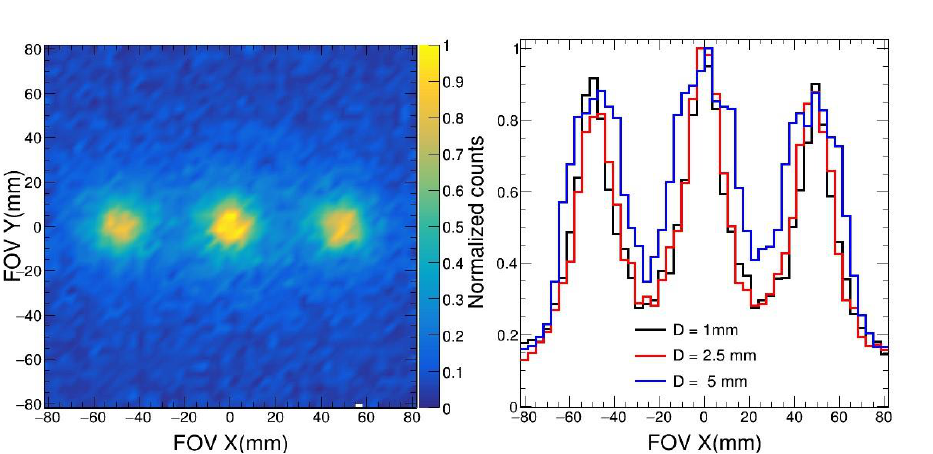
Fig. 3 . Reconstructed neutron images (left) for three isotropic point-like sources of 1 eV neutrons shown in the sketch of Fig. 2 and projections (right) along the X-axis of the images obtained with different values of the collimator aperture (D) for a fixed thickness of T = 20 mm and a focal distance F = 40